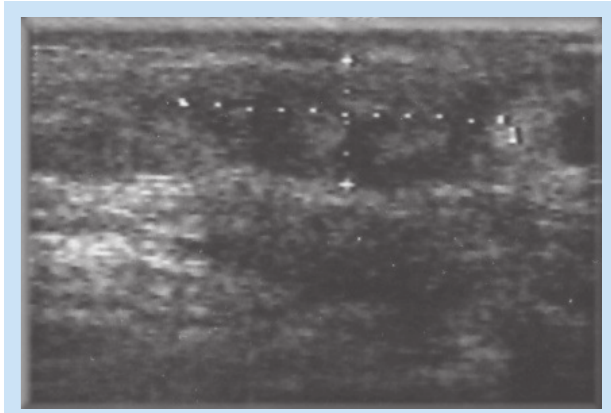
Fig. 4. US. Circumscribed mass 20 x 8 mm. Long axis parallel to the skin. No calcifications. No spiculae. No increased